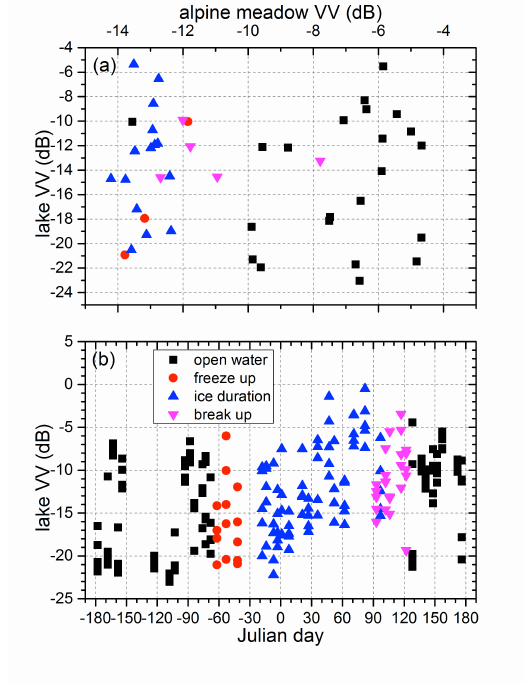
Figure 6. (a) The scatter plots of σ 0 over lake-2 versus over alpine meadow; (b) The scatter plots of σ 0 over all selected lakes versus Julian